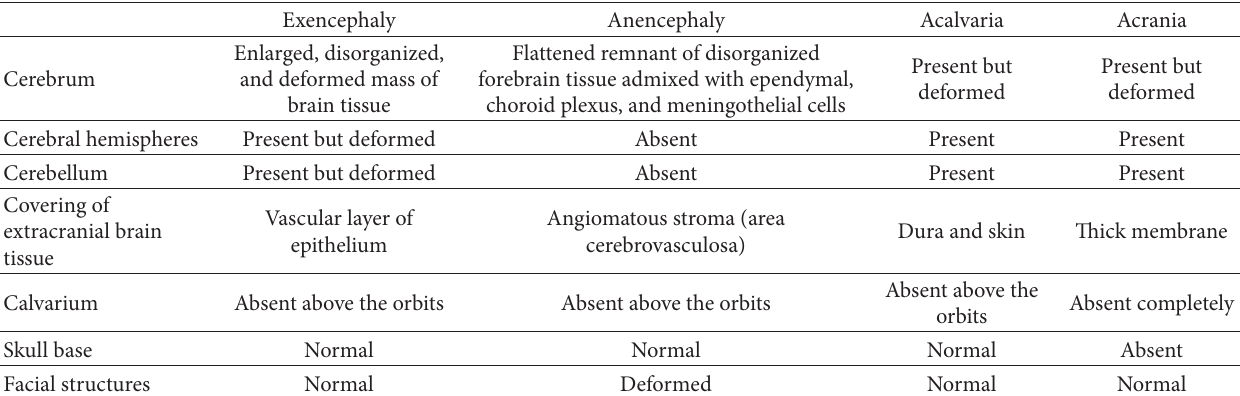
Table 1: Comparison of the four cranial vault defect